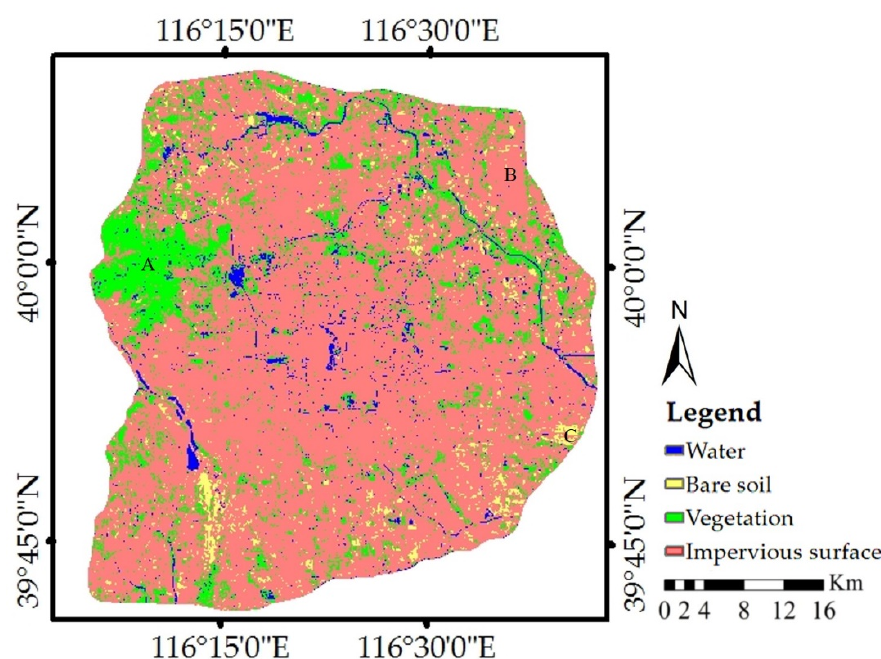
Figure 4. The classification result of the study area in the year 2017, with water, bare soil, vegetation, and high and low albedo impervious surfaces (HIS and LIS) being denoted in the blue, light yellow, green, and light coral colors.